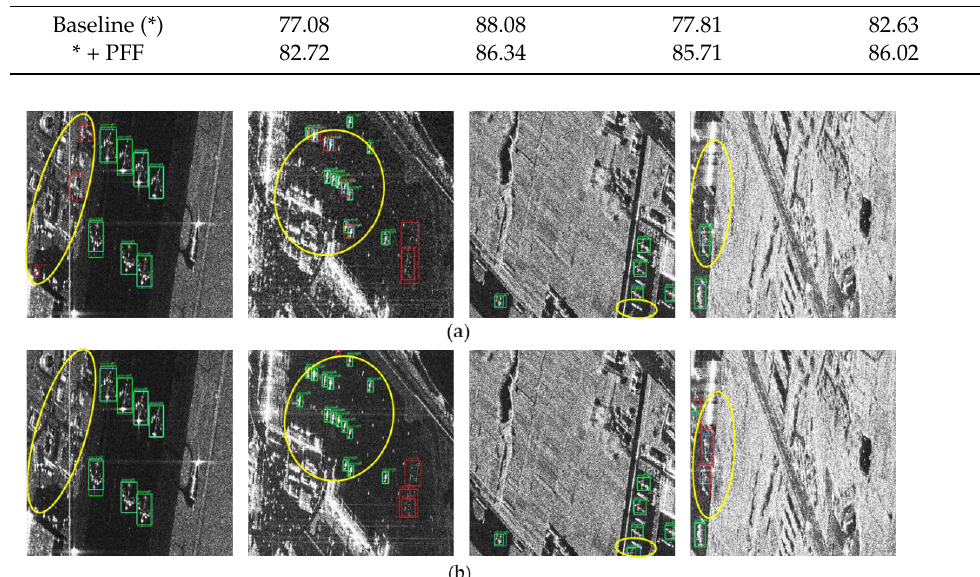
Figure 8. Detection results of two algorithms in four SAR scenes. The cyan rectangles refer to the ground truth. The green and red rectangles denote the detected targets and false alarms, respectively. For a more intuitive comparison of the differences between the two algorithms, a yellow marker is drawn on the detection results. ( a ) Baseline (*) ( b ) * + PFF.